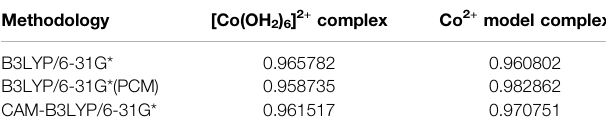
TABLE 3| Mulliken spindensitiesatthecobaltouscenterofthehexaaqua andthe model complex at different levels of